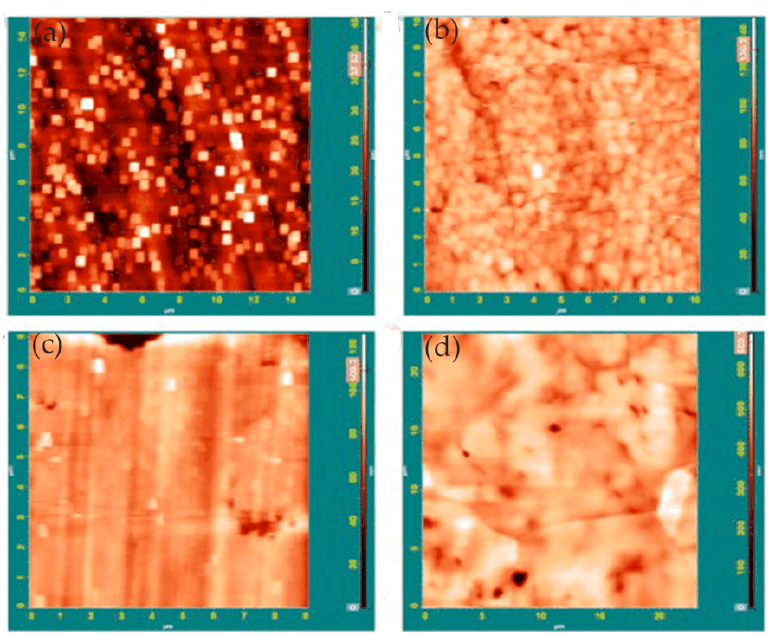
Figure 24. Surface morphology of 304L stainless steel at 1100 mV in ( a ) 0.1 M HNO 3 , ( b ) 0.5 M HNO 3 , ( c ) 0.6 M HNO 3 , and ( d ) 1 M HNO 3 . Reprinted with permission from Reference [60]; copyright 2010 Elsevier Ltd.